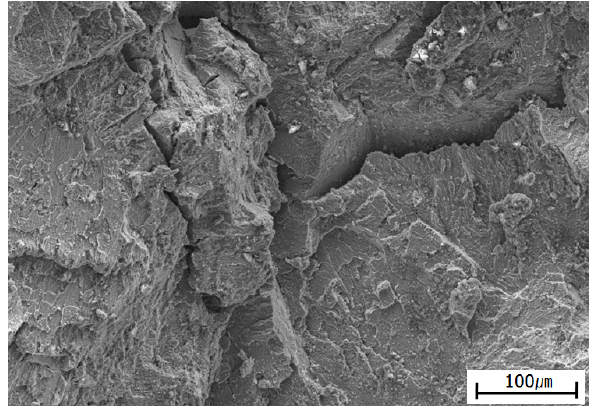
Figure 11. SEM image of cracked Ti ‐ 3Al ‐ 2.5V pipe weldment: yellow arrows indicate pores.